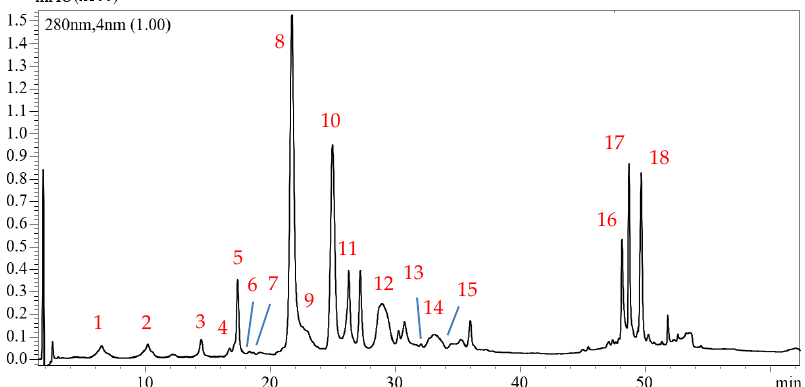
Figure 1. HPLC-PDA chromatogram of phenolic compounds present in one of the analyzed EVOO sample. 1 : Hydroxytyrosol, 2 : Tyrosol, 3 : Vanillic acid, 4 : Ligstroside derivative, 5 : p-cumaric acid, 6 :